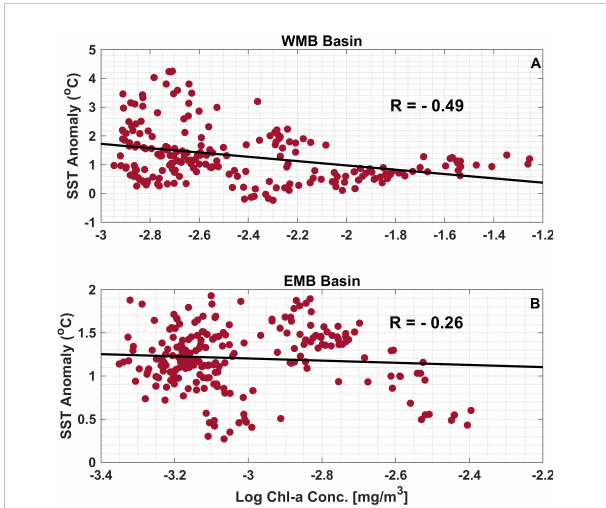
FIGURE 15 Scatter plots of daily mean SST versus log Chl-a concentration for (A) WMB and (B) EMB between June and December 2019, with the black line representing the best- fi t linear